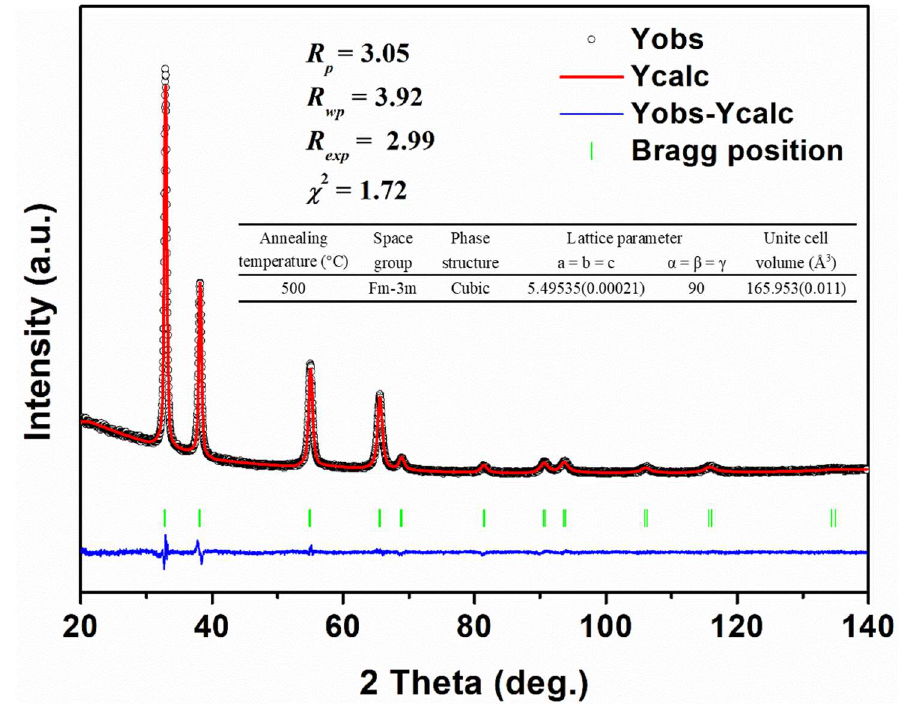
Figure 5. The XRD characterization and profile matching of the Bi 1.5 Y 0.5 O 3 film of 1.72 μm deposited on glass after annealing at 500 °C for 2 h.